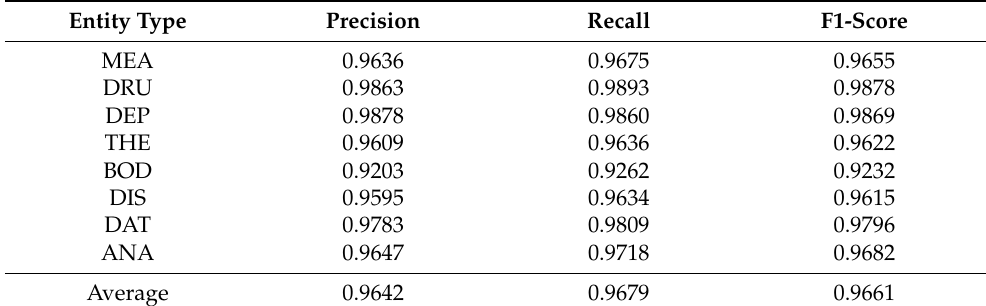
Table 8. Results obtained by the ELMo Bi-LSTM CRF trained with the final annotated corpus (AL and DS augmentation) in terms of precision, recall and F1-Score for each